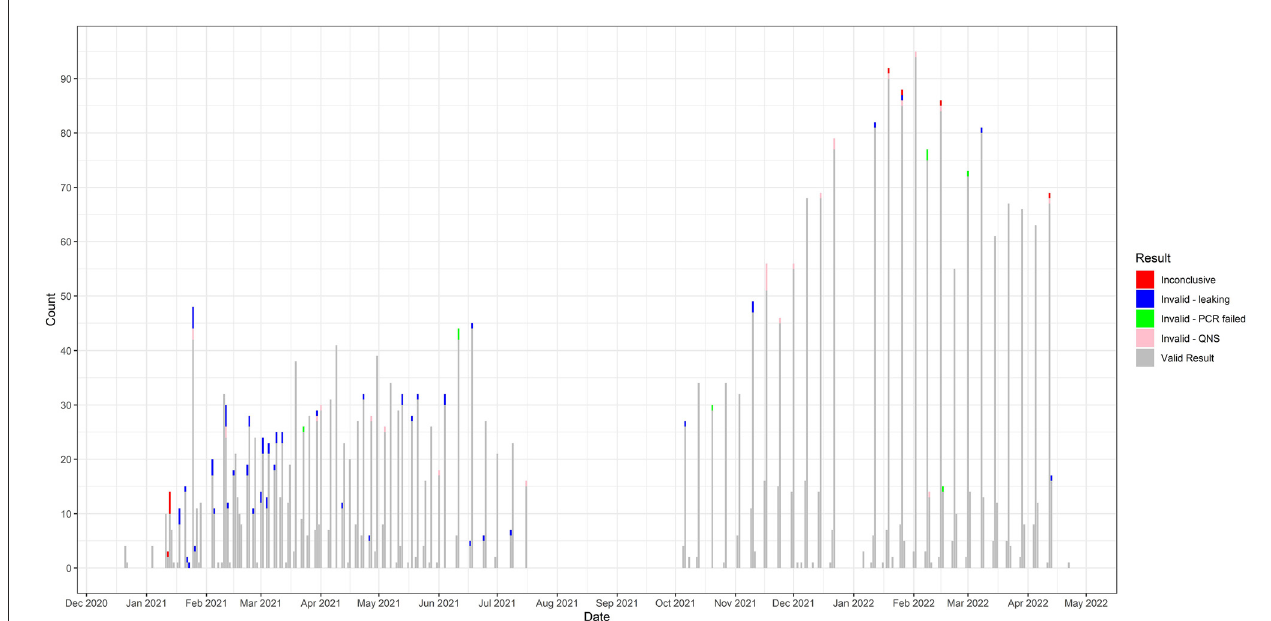
FIGURE1 Testing results over time. Counts of test results over the course of the study are shown. Results include: inconclusive, invalid due to leaking, invalid due to PCR failure, invalid due to quantity not sufficient, and valid result.